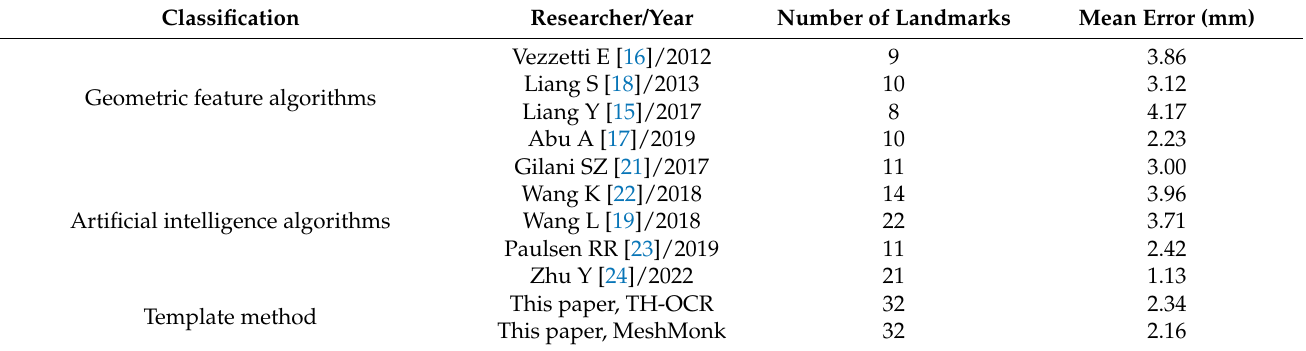
Table 4. Results of related studies on the automatic determination of 3D facial anatomical landmarks.